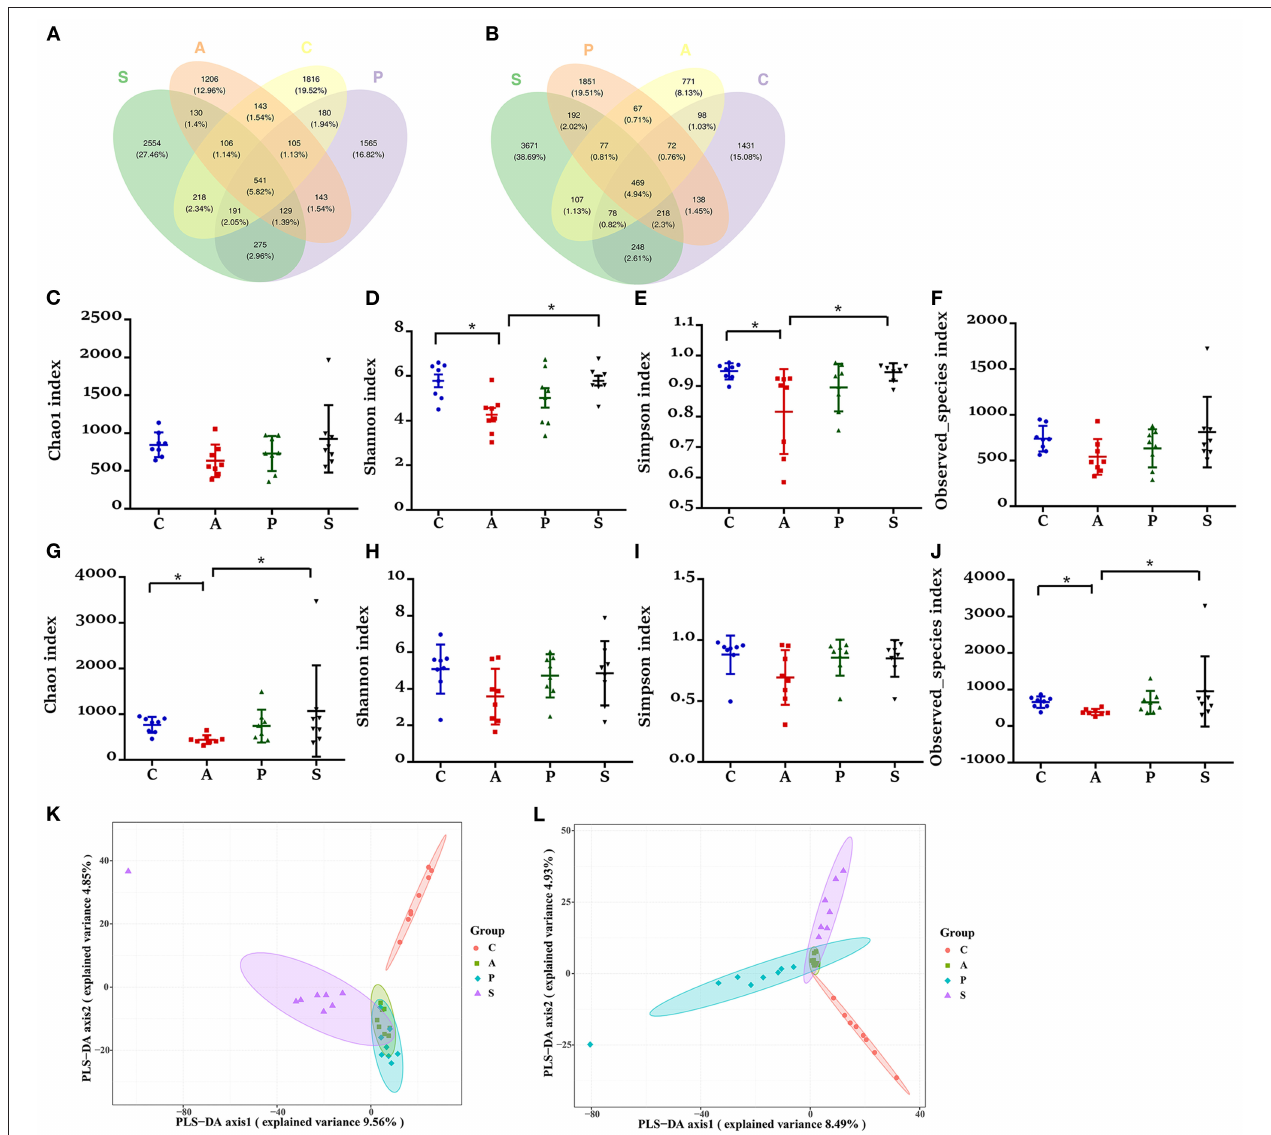
FIGURE 5 | Effects of maternal probiotic and synbiotic supplementation on microbial alpha diversity in the jejunum and ileum of offspring piglets. Venn diagrams for microbiota OTUs compositions in the (A) jejunum and (B) ileum. The microbiota diversity estimated by (C–F) Chao1, Shannon, Simpson, and Observed _ species in the jejunum and (G–J) ileum, respectively. Partial least squares discrimination analysis (PLS-DA) of (K) jejunal and (L) ileal microbiota community of offspring piglets. Data are represented as means ± SEM, n = 8 per group. * P < 0.05. C, control group; A, antibiotic group; P, probiotic group; and S, synbiotic